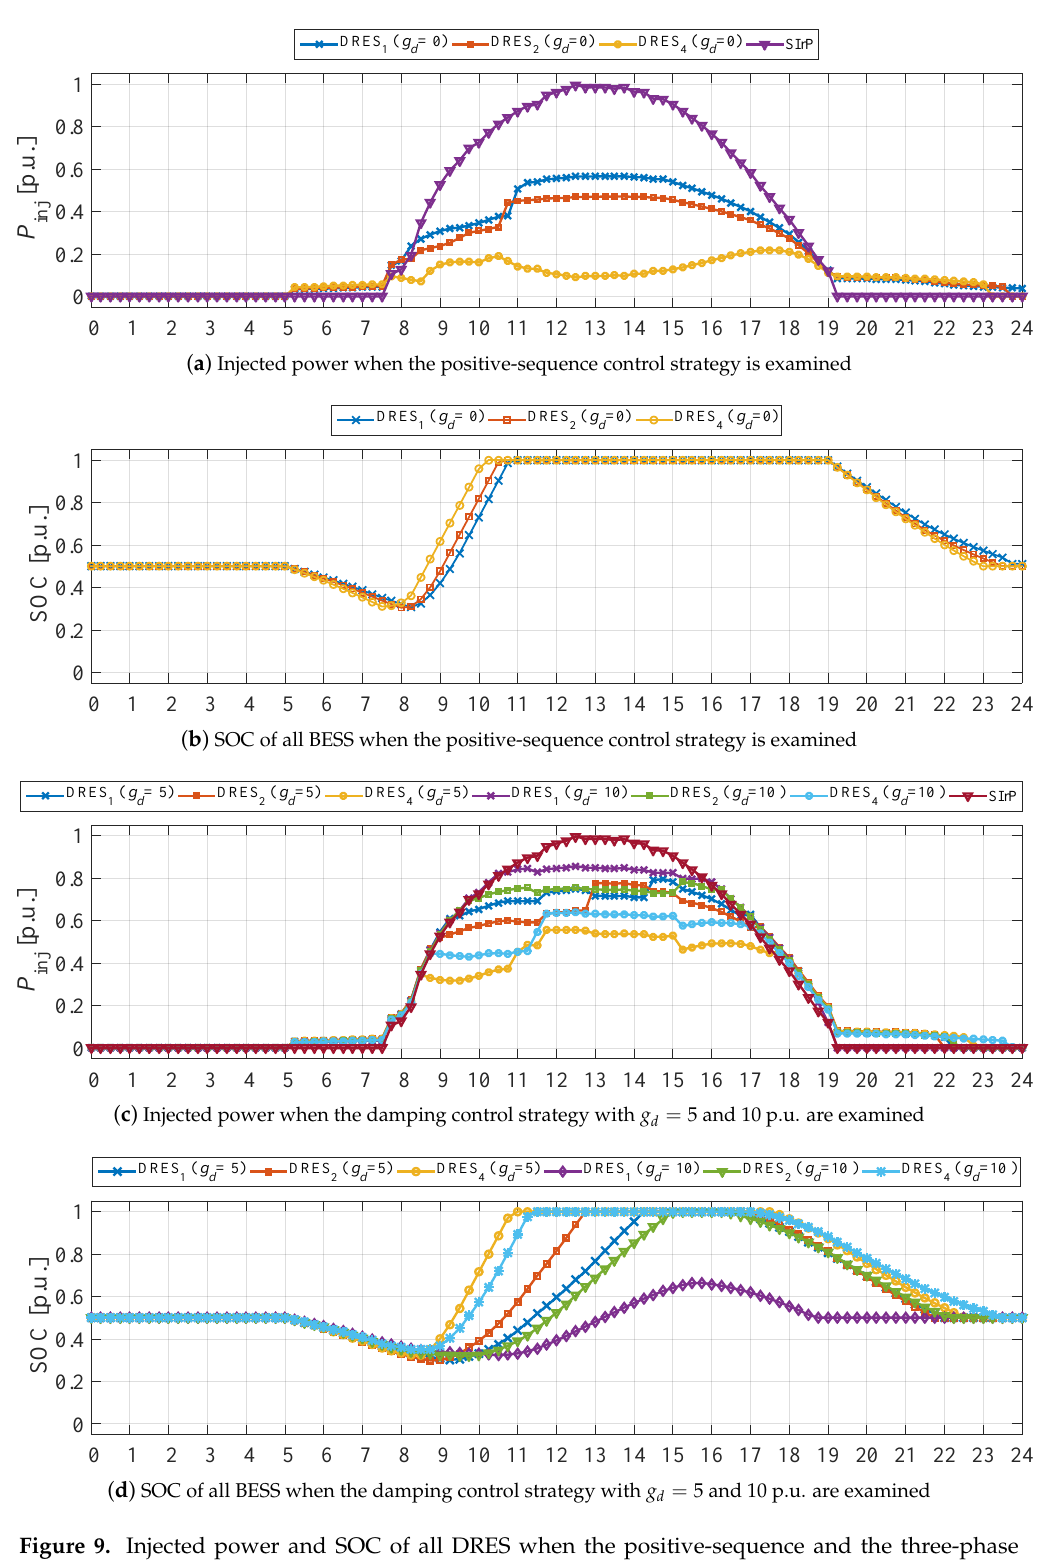
Figure 9. Injected power and SOC of all DRES when the positive-sequence and the three-phase damping control strategies are examined (C2S1, C2S2 and